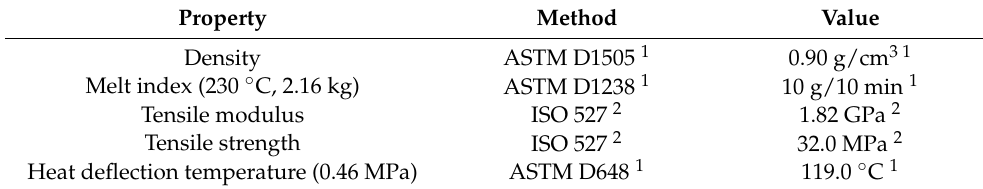
Table 1. Properties of PP (J-150).